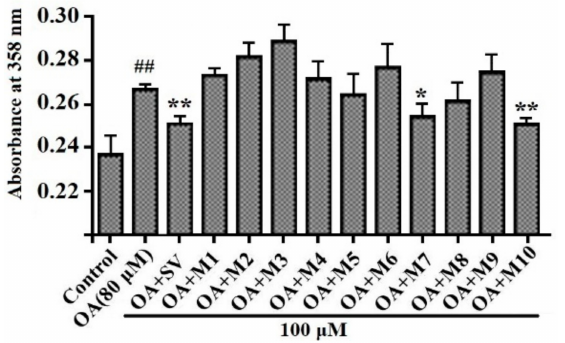
Figure 2. E ff ects of antioxidant peptides (M1–M10) from miiuy croaker ( M. miiuy ) muscle on lipid accumulation of HepG2 cells at 100 µ m. Means ± SD (n = 3) are used to express the experiment data.